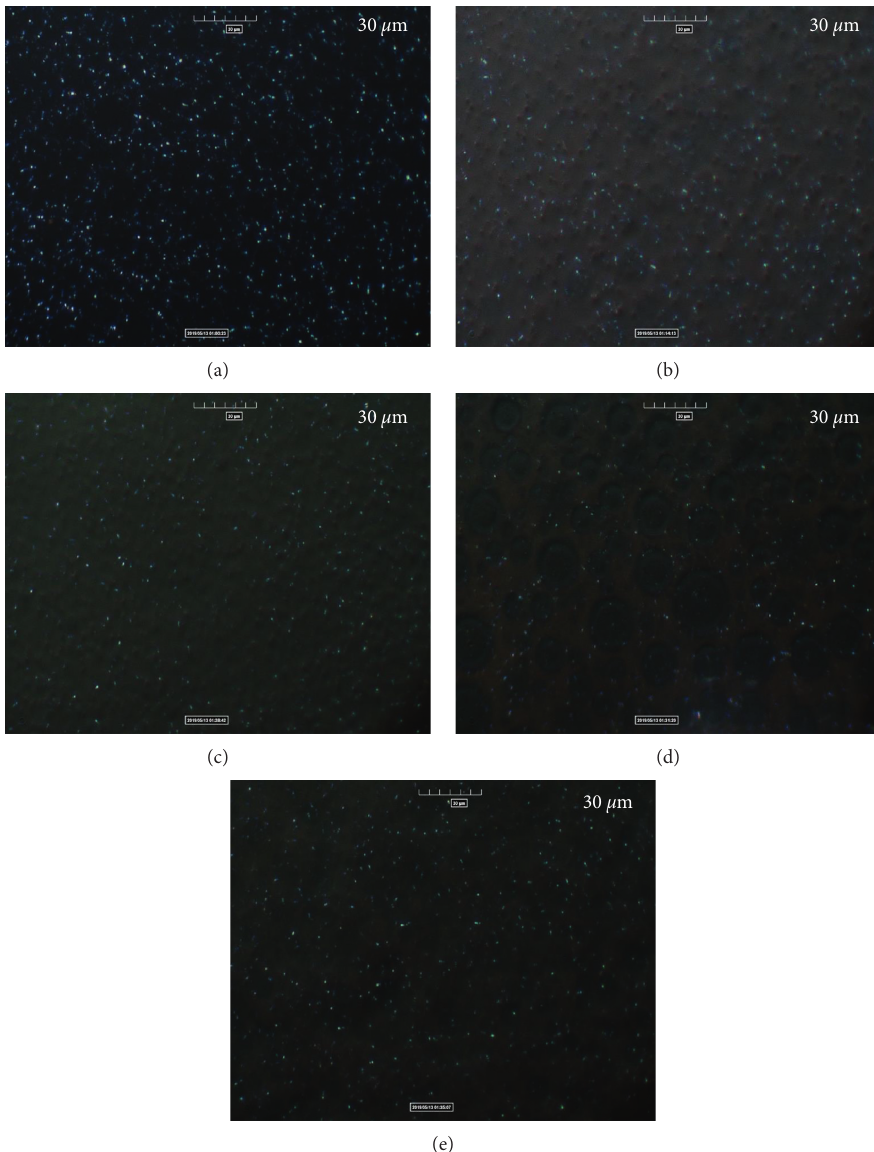
Figure 12: Optical microscopy images at original state: (a) SIS 0%, (b) SIS 5%, (c) SIS 10%, (d) SIS 15%, and (e) SIS